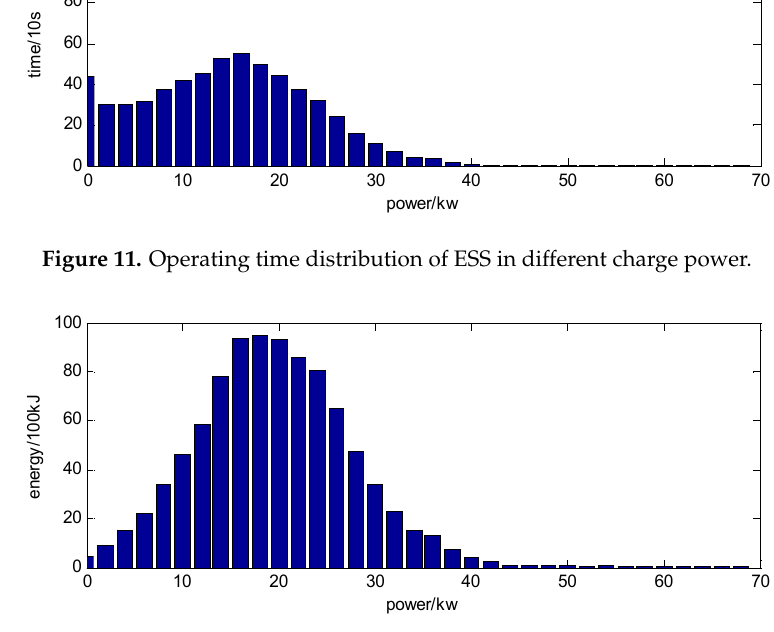
Figure 12. Output energy distribution of ESS in different charge power.